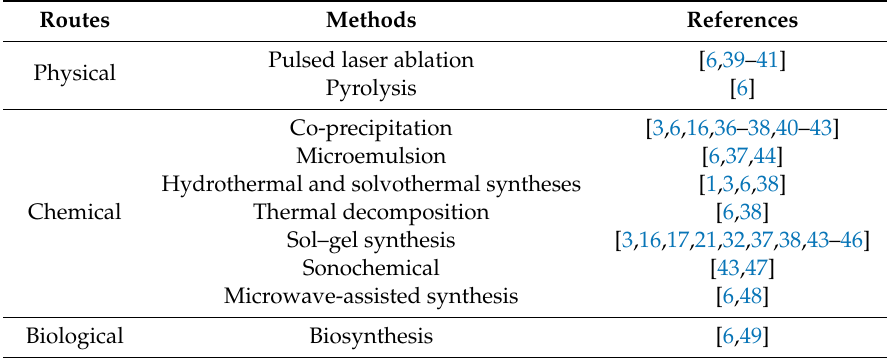
Table 1. Summary of preparation methods of iron-oxide magnetic nanoparticles